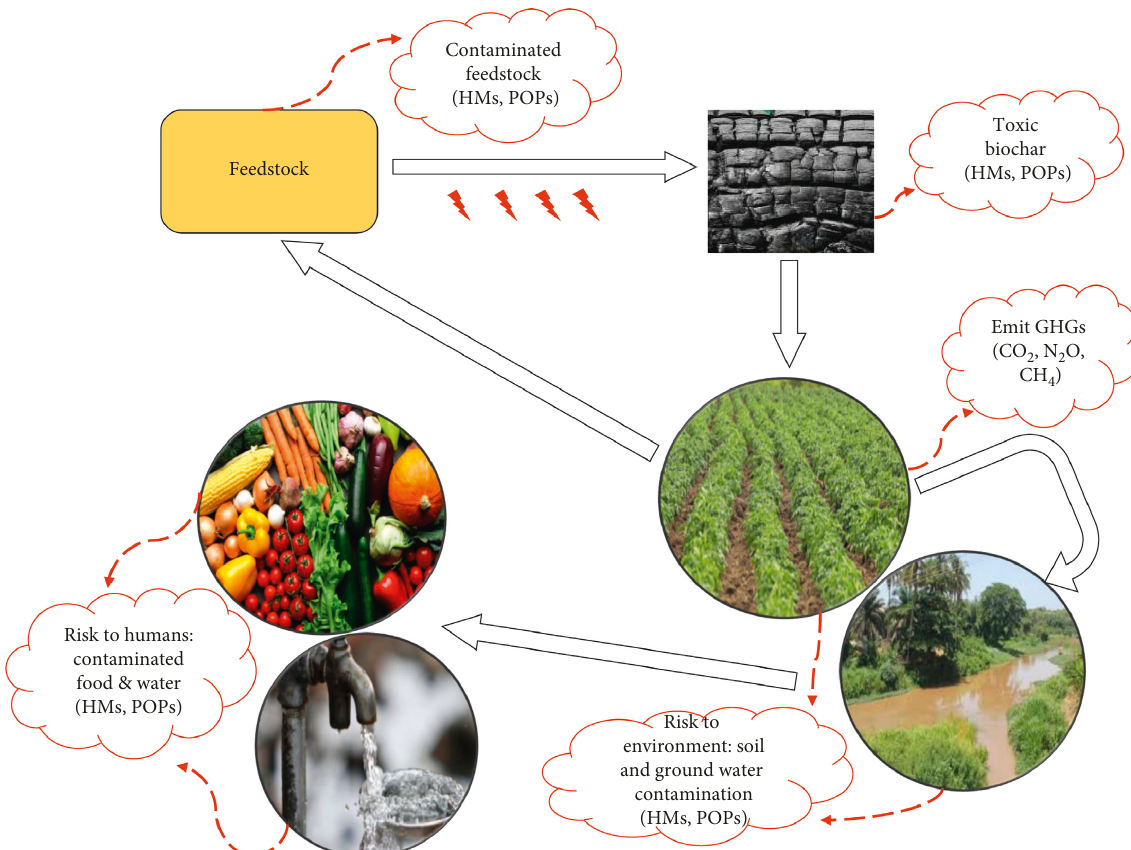
Figure 2: Risk of contaminant reaching environment and food